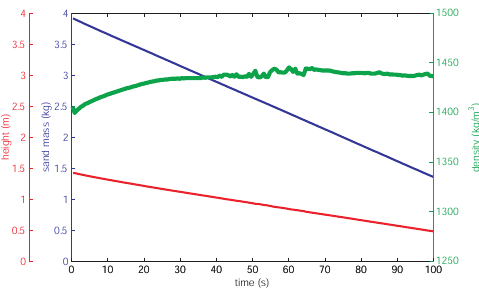
Figure 8. Mean surface height, particle mass, and density during the flow of sand particles in a perspex tube through a gap width of